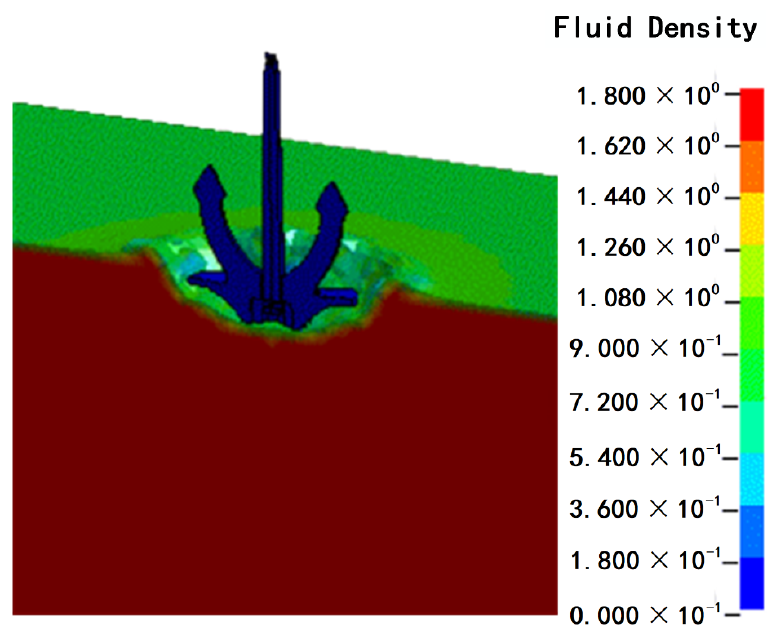
Figure 6. Numerical analysis of the penetrating process of the anchor in the soil. Table 6. The maximum penetration depths of different anchor